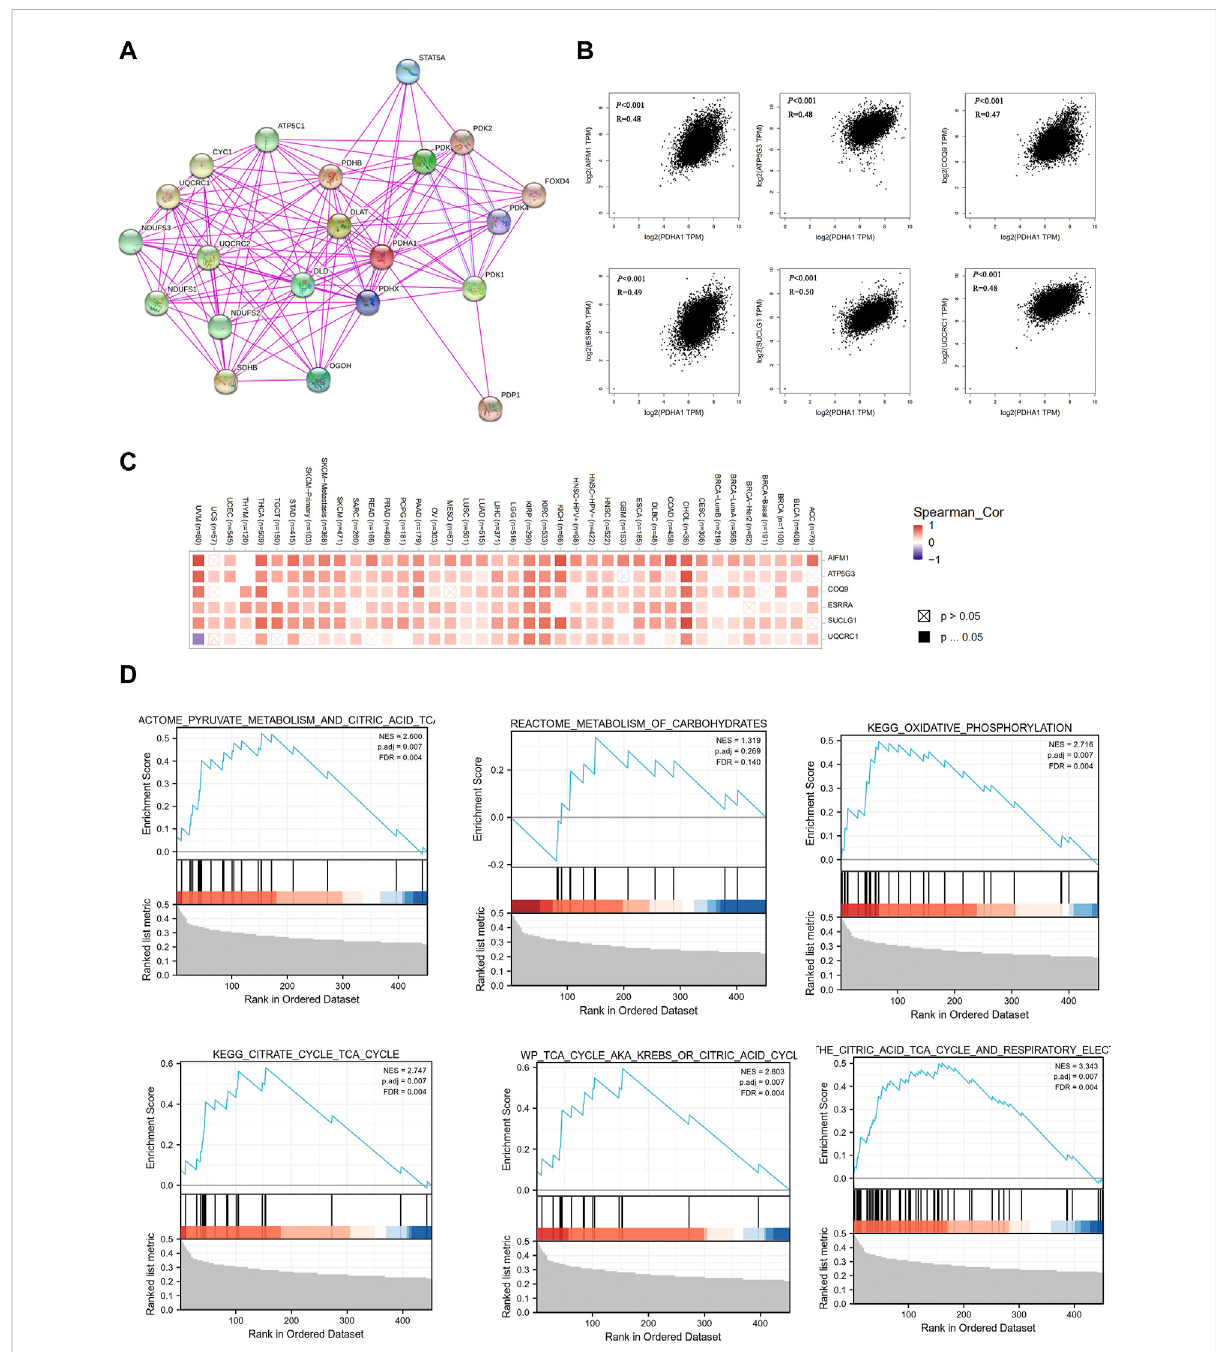
FIGURE 7 Co-expression network and enrichment pathway analysis of PDHA1. (A) In total, 20 experimentally identi fi ed PDHA1-binding molecules were acquired by STRING. (B) Top six PDHA1-correlated genes analyzed by GEPIA2, including AIFM1 , ATP5G3 , COQ9 , ESRRA , SUCLG1 , and UQCRC1 . (C) Heatmap representation of the expression correlation between PDHA1 and the top six PDHA1-correlated genes, AIFM1 , ATP5G3 , COQ9 , ESRRA , SUCLG1 , and UQCRC1 , in 33 tumors. (D) Roles of PDHA1 in the metabolism signaling pathway by performing